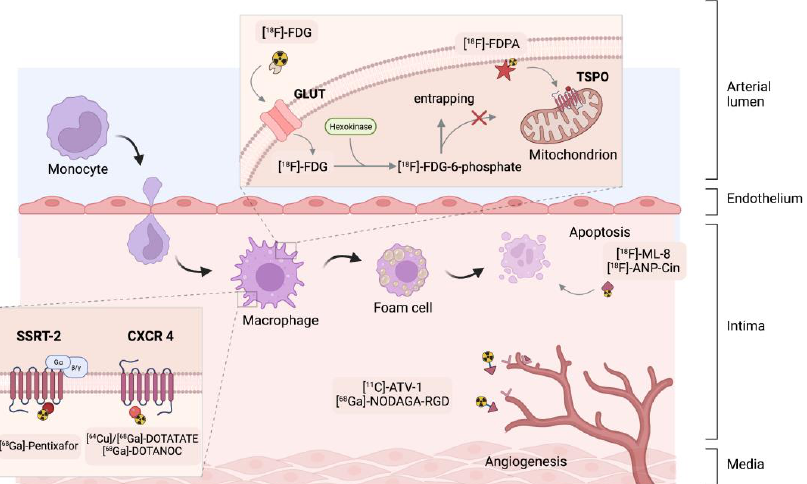
Figure 2. Summary of the key mechanisms of PET cardiovascular tracers. [ 18 F]-ANP-Cin = [ 18 F]-AlF-NOTA-PEG3-Cinnamycin, [ 11 C]-ATV-1 = carbon-11-labelled pan-angiogenic receptor inhibitor, [18F]-FDG = [18F]-fluorodeoxyglucose, [ 18 F]-FDPA = N,N-diethyl-2-(2-(4-(2-fluoroethoxy)phenyl)-5,7-dimethylpyrazolo [1,5-a]pyrimidin-3-yl)acetamide, [ 68 Ga]-DOTATATE = [ 68 Ga]-1,4,7,10-tetraaza-cyclododecane-1,4,7,10-tetraacetic acid-D-Phe1-Tyr3-octreotate, NOC = 1-Nal3-octreotide, RGD = arginine -glycine-aspartic acid, NODAGA = 2-[1,4,7-Triazacyclononan-1-yl-4,7-bis(tBu-ester)]-1,5-pentanedioic acid, [18F]-ML- 8 = 2 -(3-[18F]fluoropropyl)-2-methyl- malonic acid, SSTR = somatostatin receptor sub -type 2, CXCR 4 = CXC-motif chemokine-receptor 4, GLUT = glucose transporter, TSPO = translocator protein.